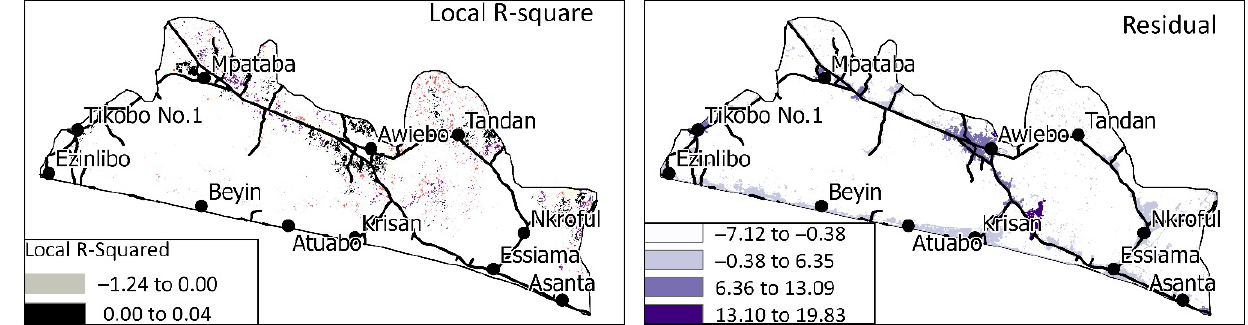
Figure 11. Results of geographically weighted regression showing spatial variations in the relationships between elevation, slope, distance from road and land use/land cover transitions to cropland. Positive coefficients indicate the magnitude of spatial variation. Negative coefficients indicate no spatial correlations between the factor and transitions to cropland.